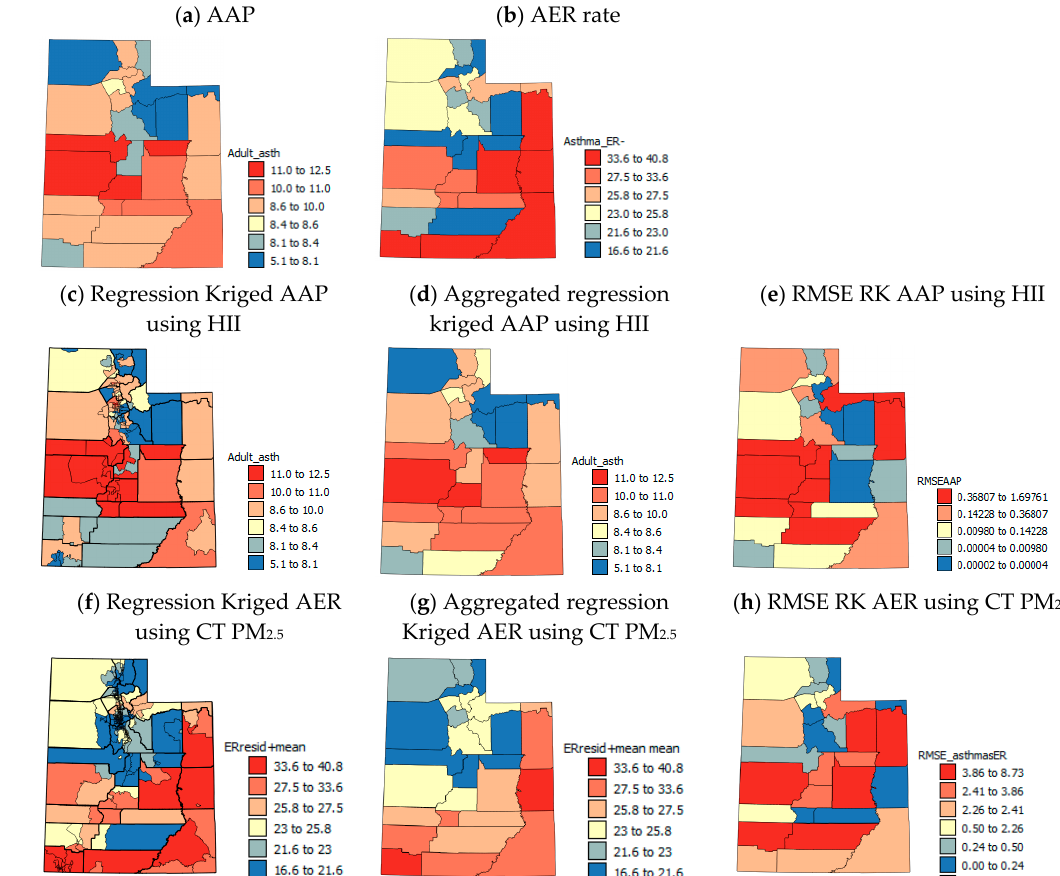
Figure 2. Maps of health outcome variables.